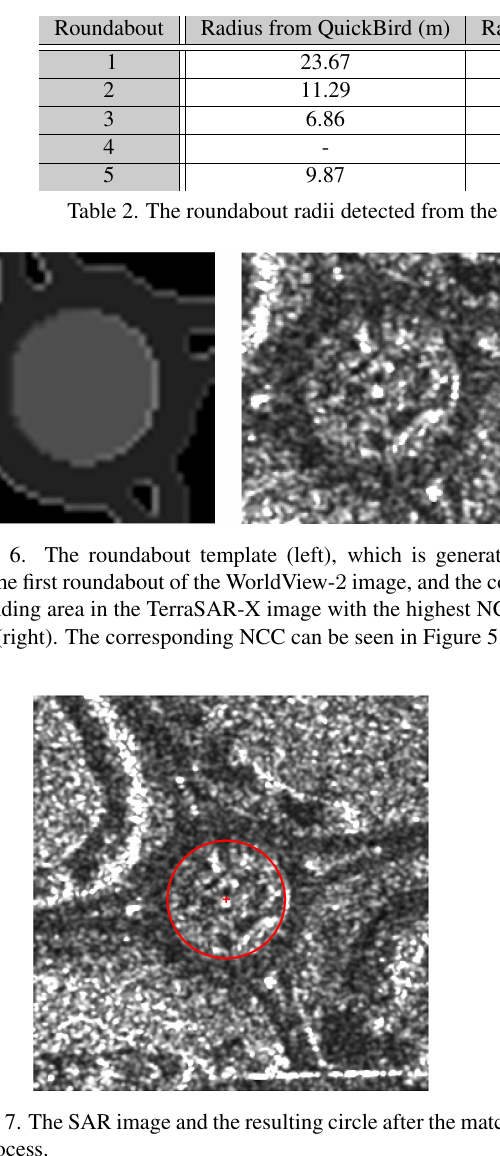
Table 1. Details of TerraSAR-X, WorldView-2, QuickBird and the reference images.